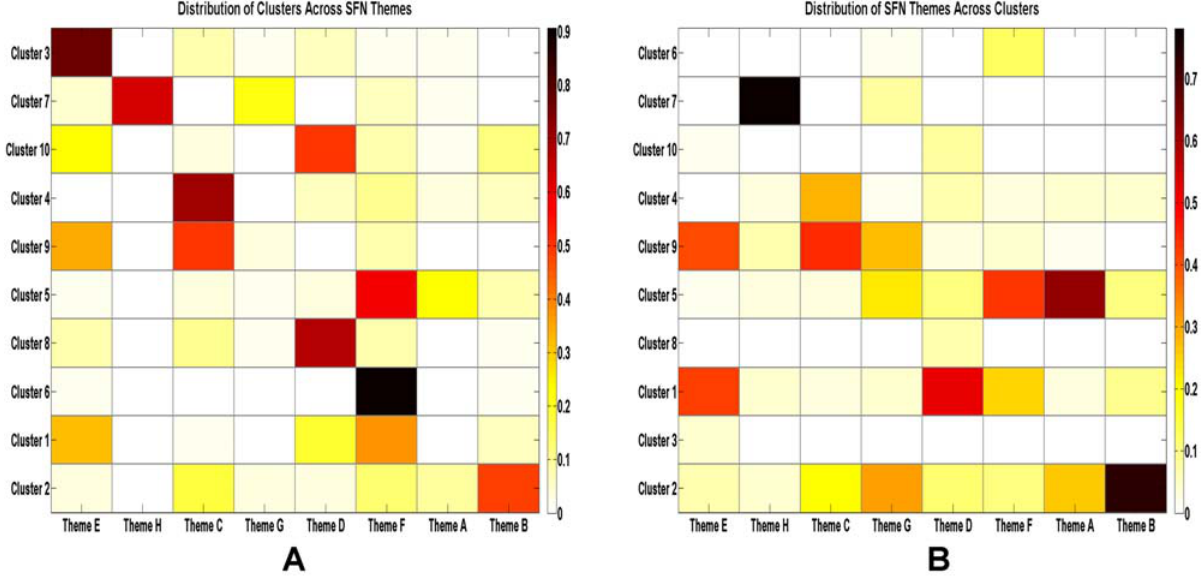
Figure 9. (A) Concordance matrix between NCuts clusters and SFN themes, normalized by cluster size in each row. The matrix has been diagonalized for clarity. (B) Concordance matrix between NCuts clusters and SFN themes, normalized by theme size in each column. The matrix has been diagonalized for clarity.